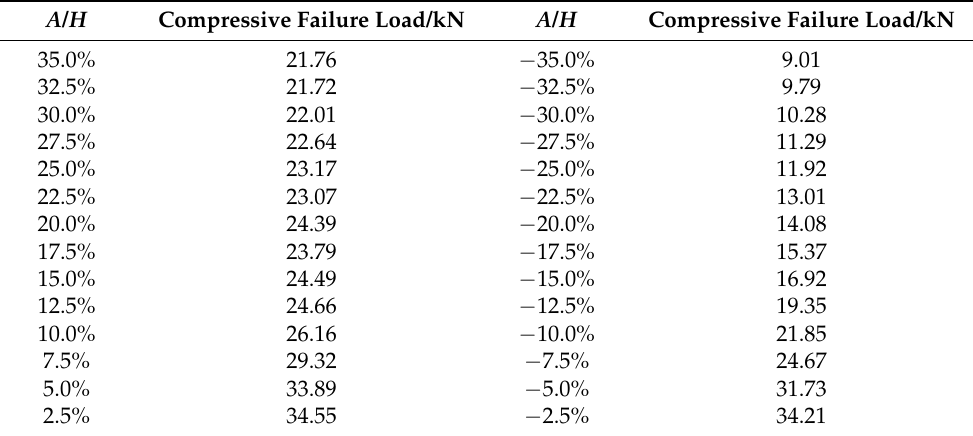
Table 5. Predicted compressive failure load with different A/H.